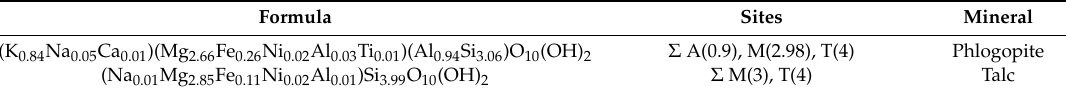
Table 3. The average mineral compositions from the mica zone (see Figure 6c).